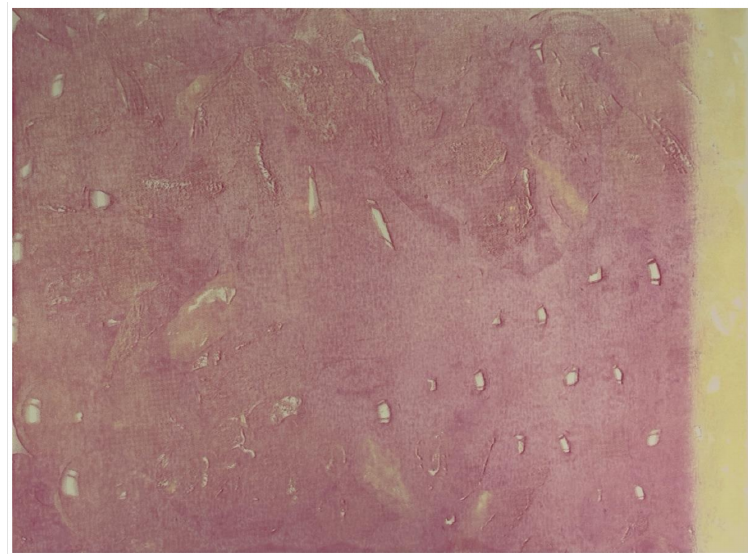
Figure A2. 25LPI, direct litho, Iriodin™ Solar Gold on yellow plate overprinted with magenta, white Plike, film positive, print size: 600 mm × 450 mm.